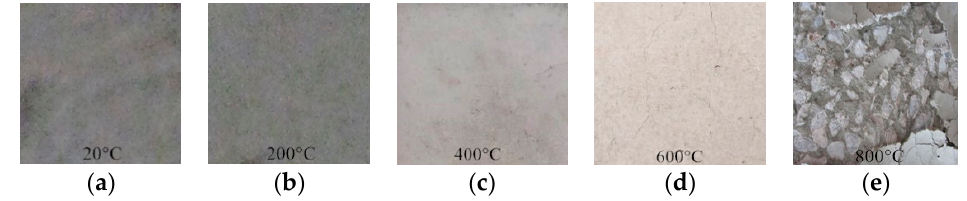
Figure 6. Apparent morphology of specimen after high temperatures. ( a ) 20 °C; ( b ) 200 °C; ( c ) 400 °C; ( d ) 600 °C; ( e ) 800 °C.